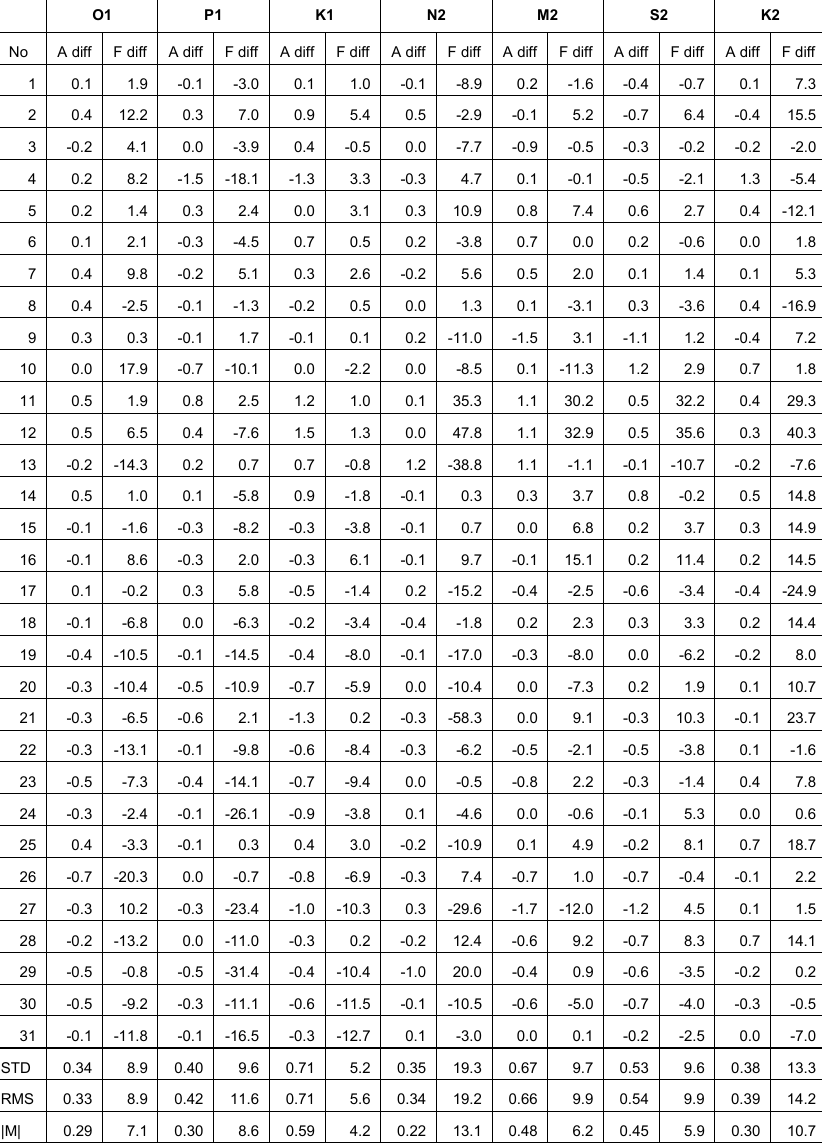
Table 3. Amplitude and phase differences between observation and model results for sea level at 31 gauge stations. Differences in amplitudes are in cm and phases are in degrees. The last three lines represent the basic statistical parameters: standard deviation (STD), root mean square error (RMS) and absolute mean differences ( | M | ). O1 P1